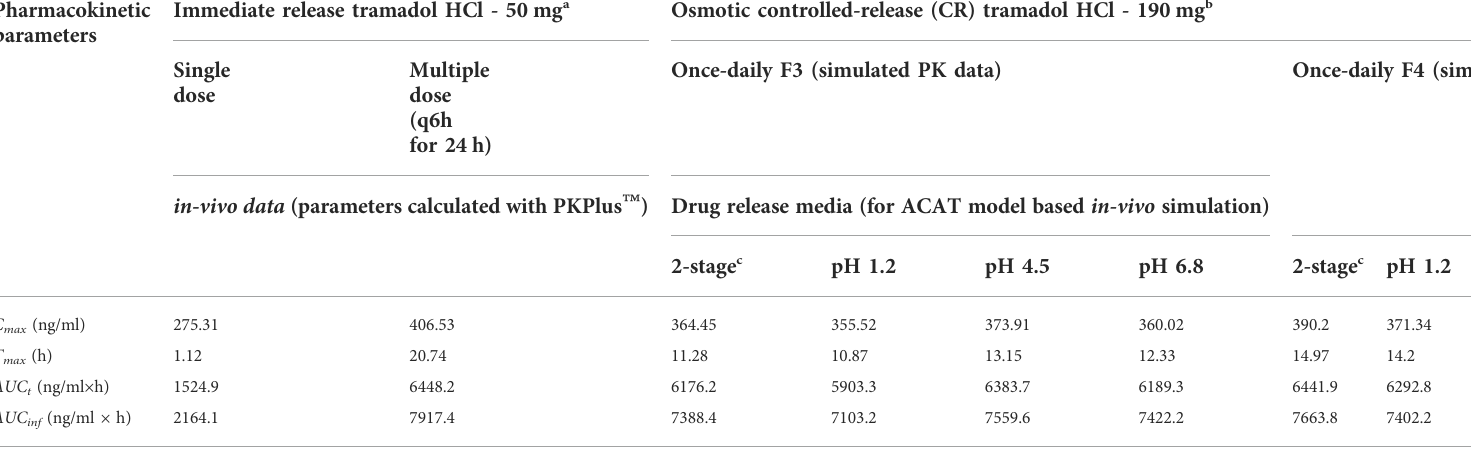
TABLE 8 Calculated and predicted pharmacokinetic parameters of tramadol HCl